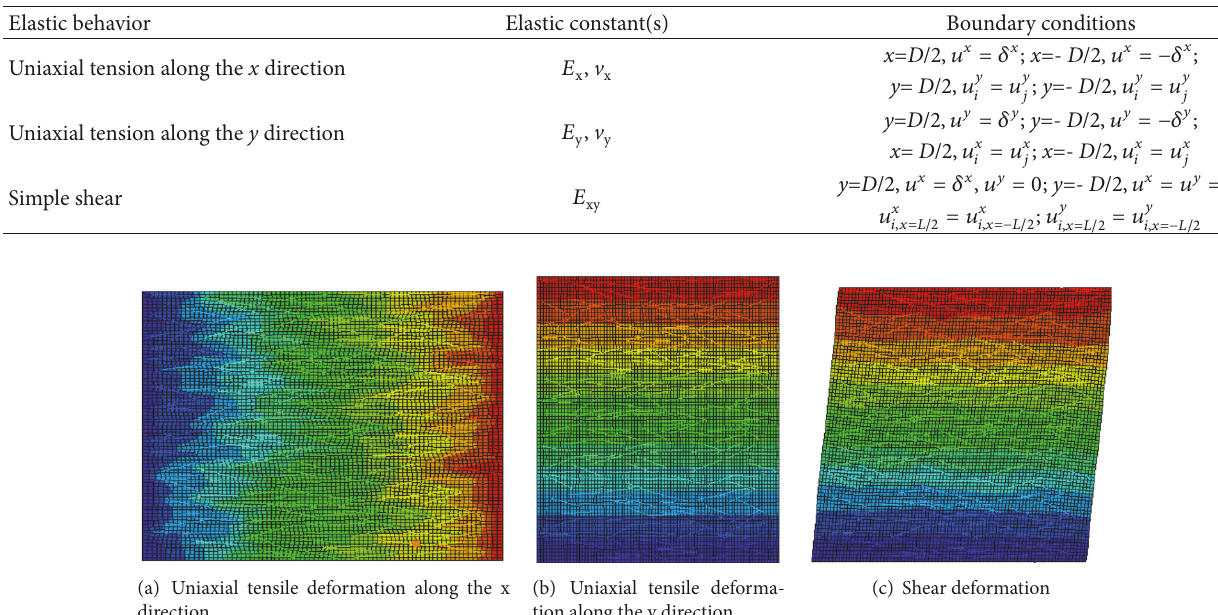
Table 1: Boundary conditions for the different elastic constants.